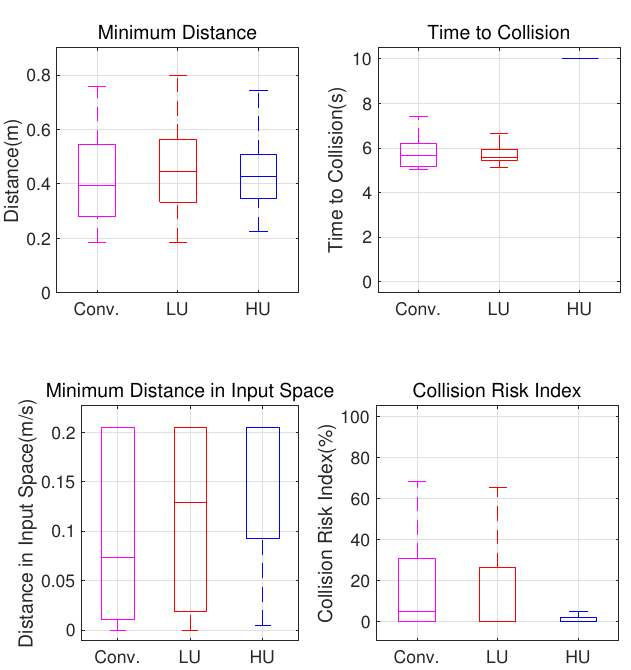
Figure 10. Comparisons of the navigation safety